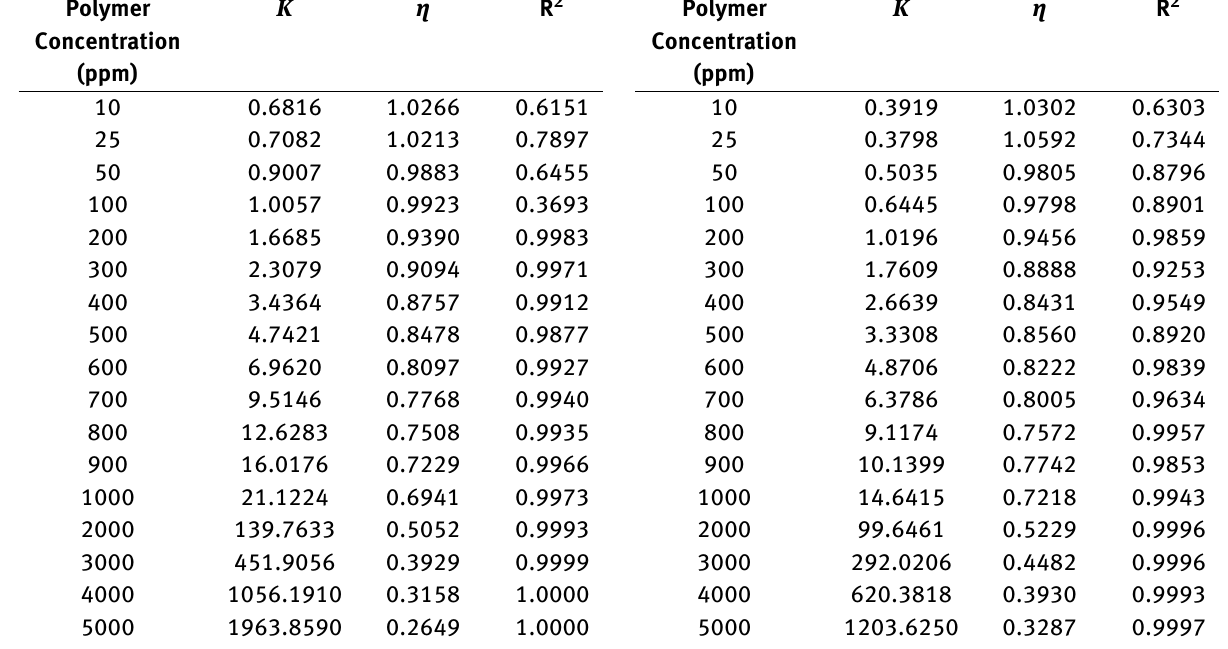
Table 7: Fit parameters to the Power Law Model for 50 ∘ C/110,000 ppm NaCl Polymer